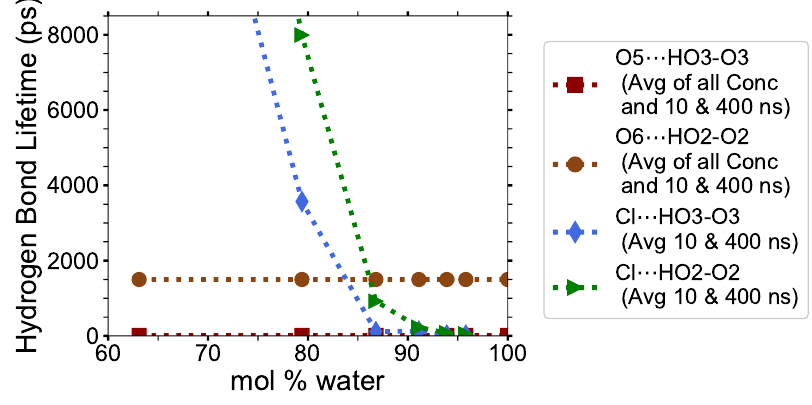
Figure 10. The chloride’s intra-strand hydrogen bond breaking lifetimes vs. the cellulose’s intra-strand hydrogen bonding lifetimes. The cellulose’s intra-strand hydrogen bonding, O5 · · · HO3-O3 and O6 · · · HO2-O2, should remain relatively constant as it is mostly undissolved. Therefore, the intra-strand hydrogen bonding were averaged for all the concentrations and sample times (10 and 400